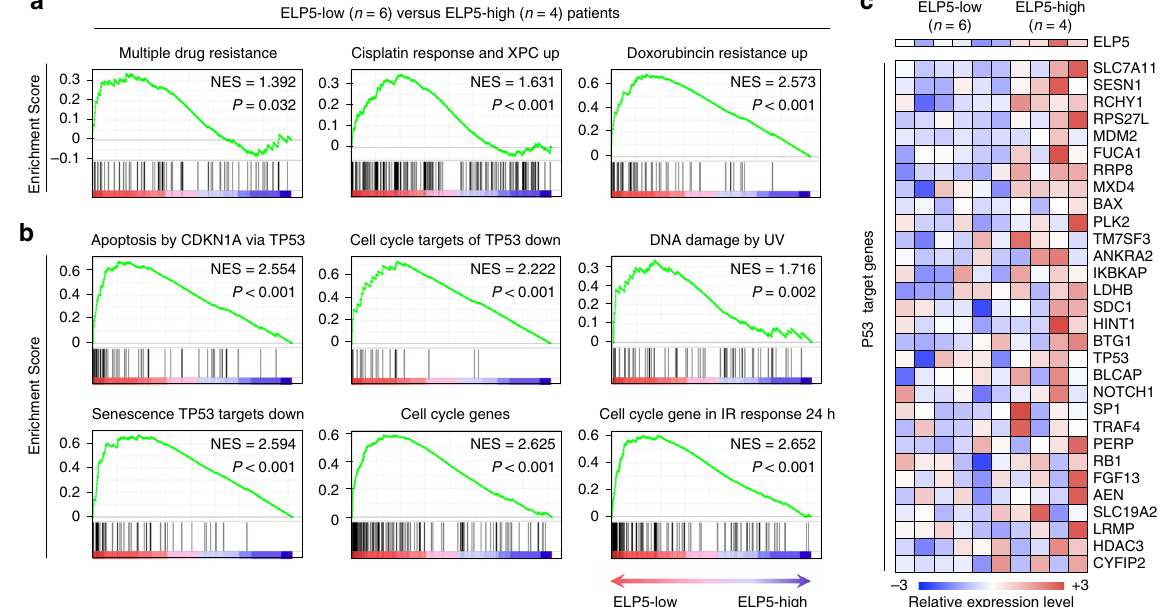
Fig. 4 Lower ELP5 expression is correlated with drug resistance and downregulated P53 function in GBC patients. a Drug resistance-related biological signatures were enriched GBC specimens with low ELP5 expression. b Cell cycle, DNA damage, senescence, and P53-related biological signatures were dysregulated in GBC specimens with low ELP5 expression. c Heat map of P53 target genes that were downregulated in GBC specimens with low ELP5 expression ( n = 6) compared to those with high ELP5 expression ( n = ELP5 − / − cells (Fig. 5d). Both WT and ELP5 − / − cells expressed